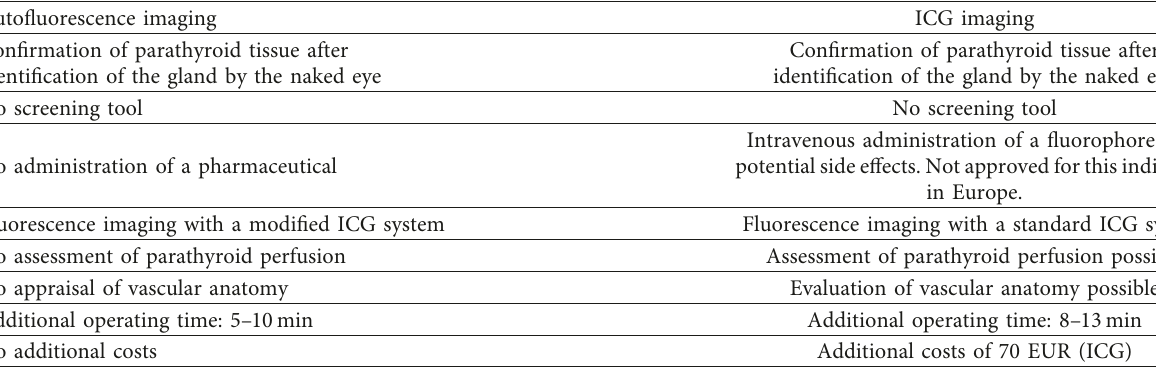
Table 3: Comparison of autofluorescence and ICG imaging of parathyroid